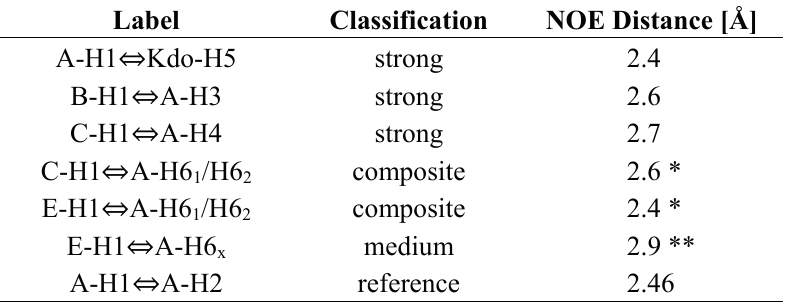
Table 2. Inter-residue NOE data obtained for lgt1/4 Δ OS. Distance constraints used for classification: strong 1.8–2.8 Å, medium 1.8–3.3 Å and weak 1.8–5.0 Å. The effective